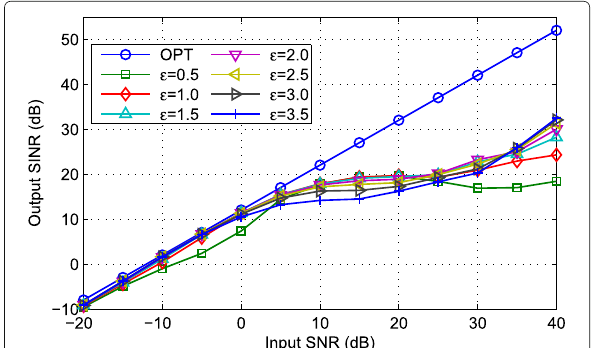
Fig. 6 The convergence properties of IRAB and IWCB: SINR versus iterative